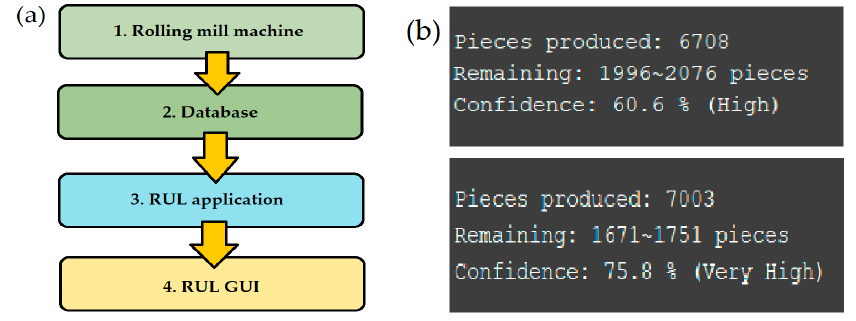
Figure 3. ( a ) Layered architecture of the implemented approach, ( b ) examples of RUL GUI indications.